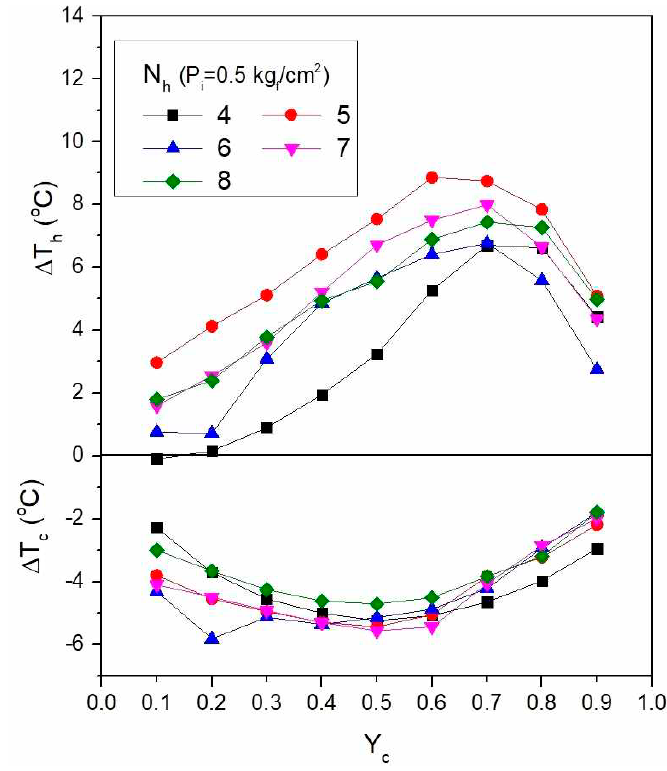
∆ T c according to inlet pressure (P i ) 0.5 kgf h and